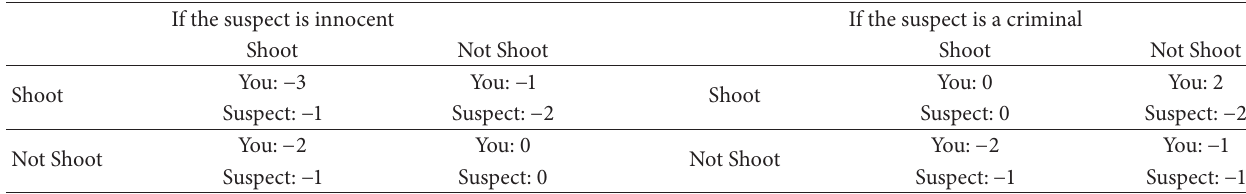
Table 7: Payoff matrix of A Sheriff’s Dilemma.